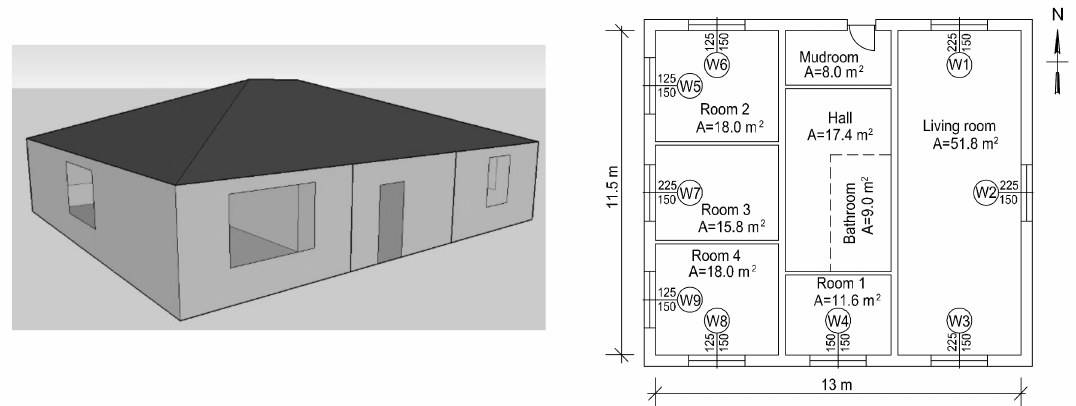
Figure 3. View of the building and ground floor view (widow dimensions are in cm).